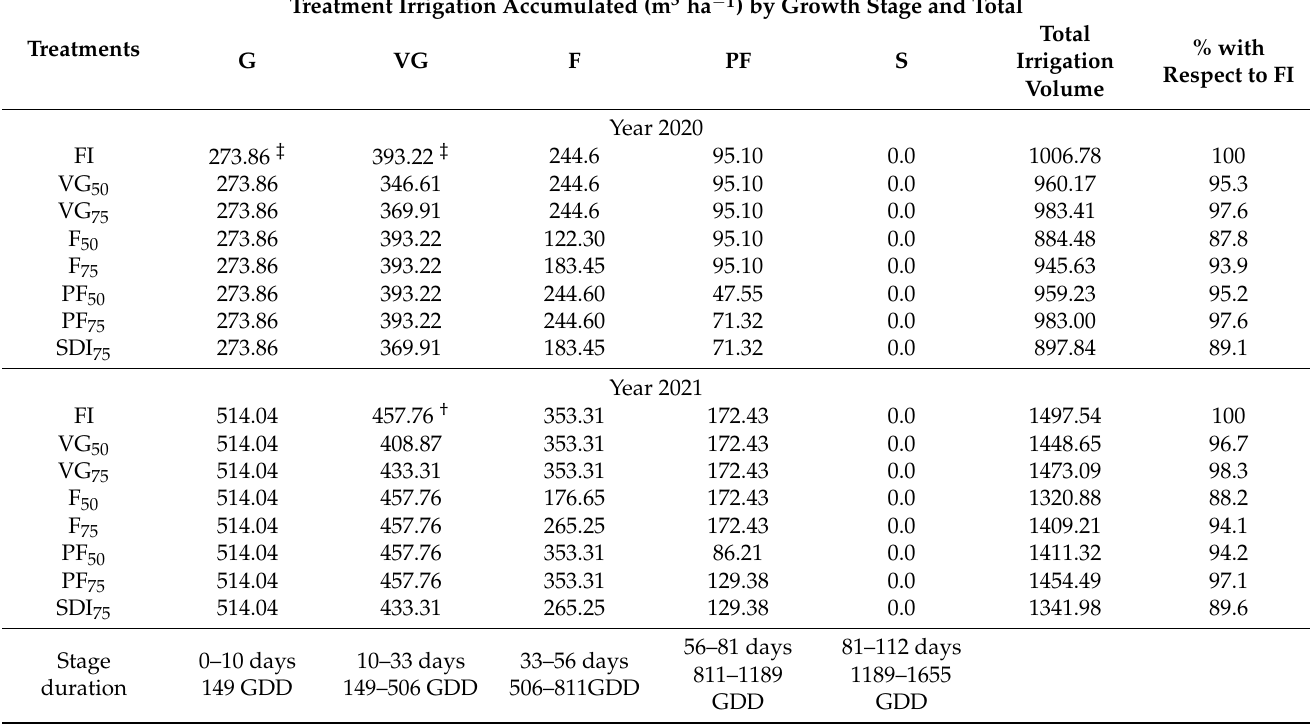
Table 4. Deficit irrigation treatments and total irrigation by growth stage applied to chickpeas during two consecutive years of experiments (2020 and 2021) at Todos Santos, Baja California Sur,